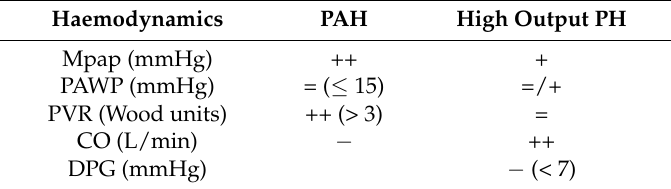
Haemodynamics in pulmonary hypertension associated with hereditary haemorrhagic telangiectasia.